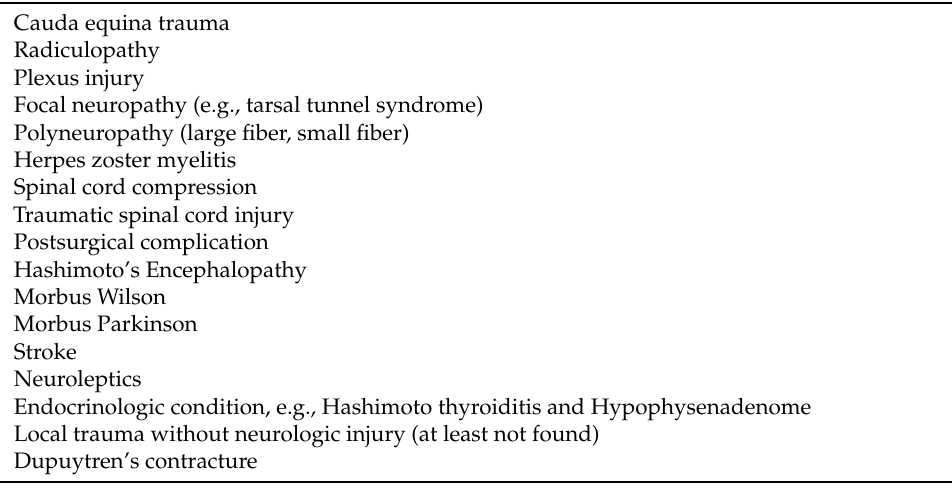
Table 1. Potential Conditions Associated with the Development of